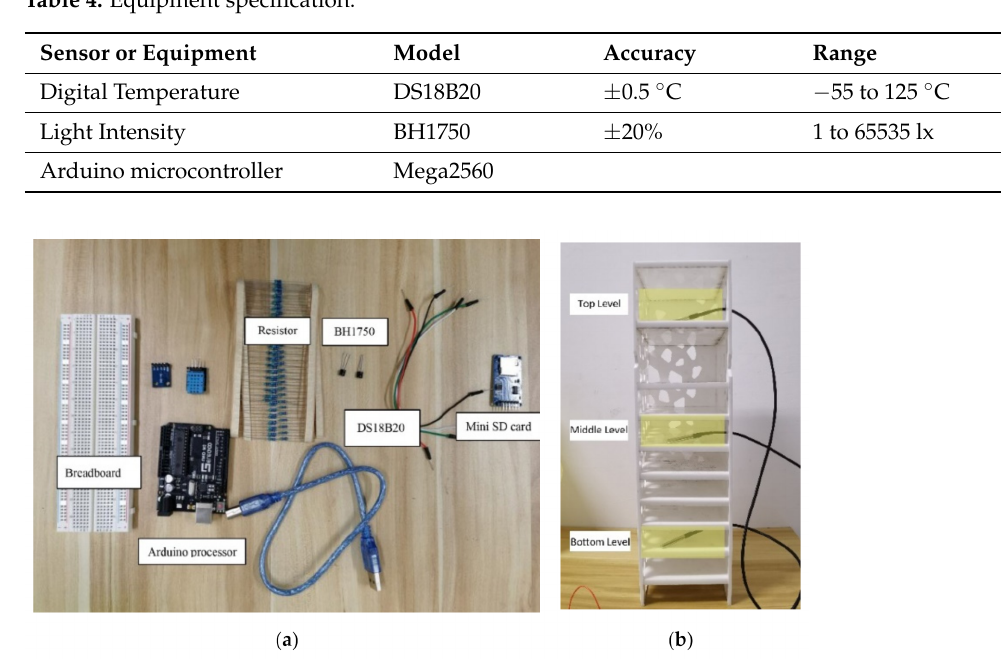
Figure 18. ( a , b ): the hardware of Arduino and the